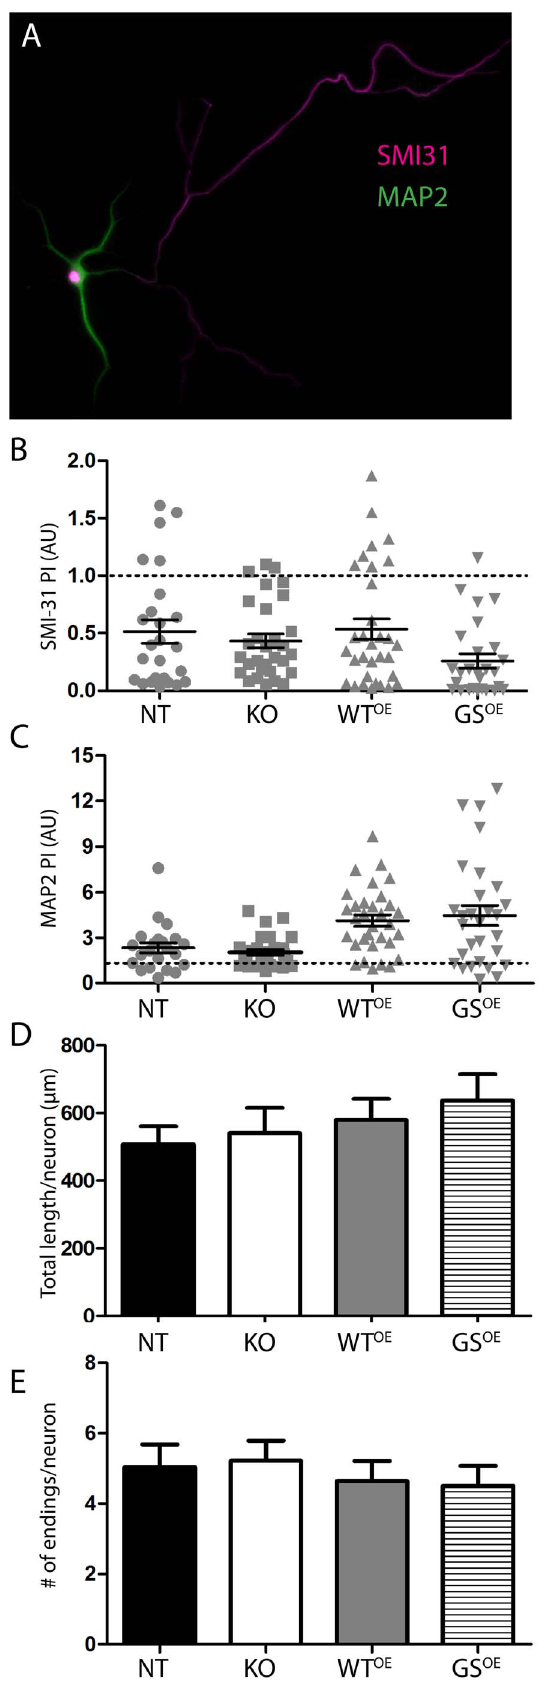
Figure 1. LRRK2 levels or mutation do not affect axonal development or branching. (A) Image of a 3 DIV LRRK2-WT OE transgenic neuron immunolabeled for SMI-31 (magenta) and MAP2 (green) illustrates the normal polarization of proteins achieved in neurons from all genotypes. Scatter plots of polarity indices (PI) calculated for 3 DIV neurons of each genotype for SMI-31 (B) and for MAP2 (C). Mean 6 SEM indicated by horizontal line and error bars. At least 10 neurons from two culture preparations each (at least 20 neurons total) were analyzed per genotype. Bar graphs of mean axon lengths (D) and mean number of axon terminal endings (E) measured in fixed 3 DIV neurons ( 6 SEM). At least 10 neurons from at least two culture preparations each (at least 20 neurons total) were traced and measured per